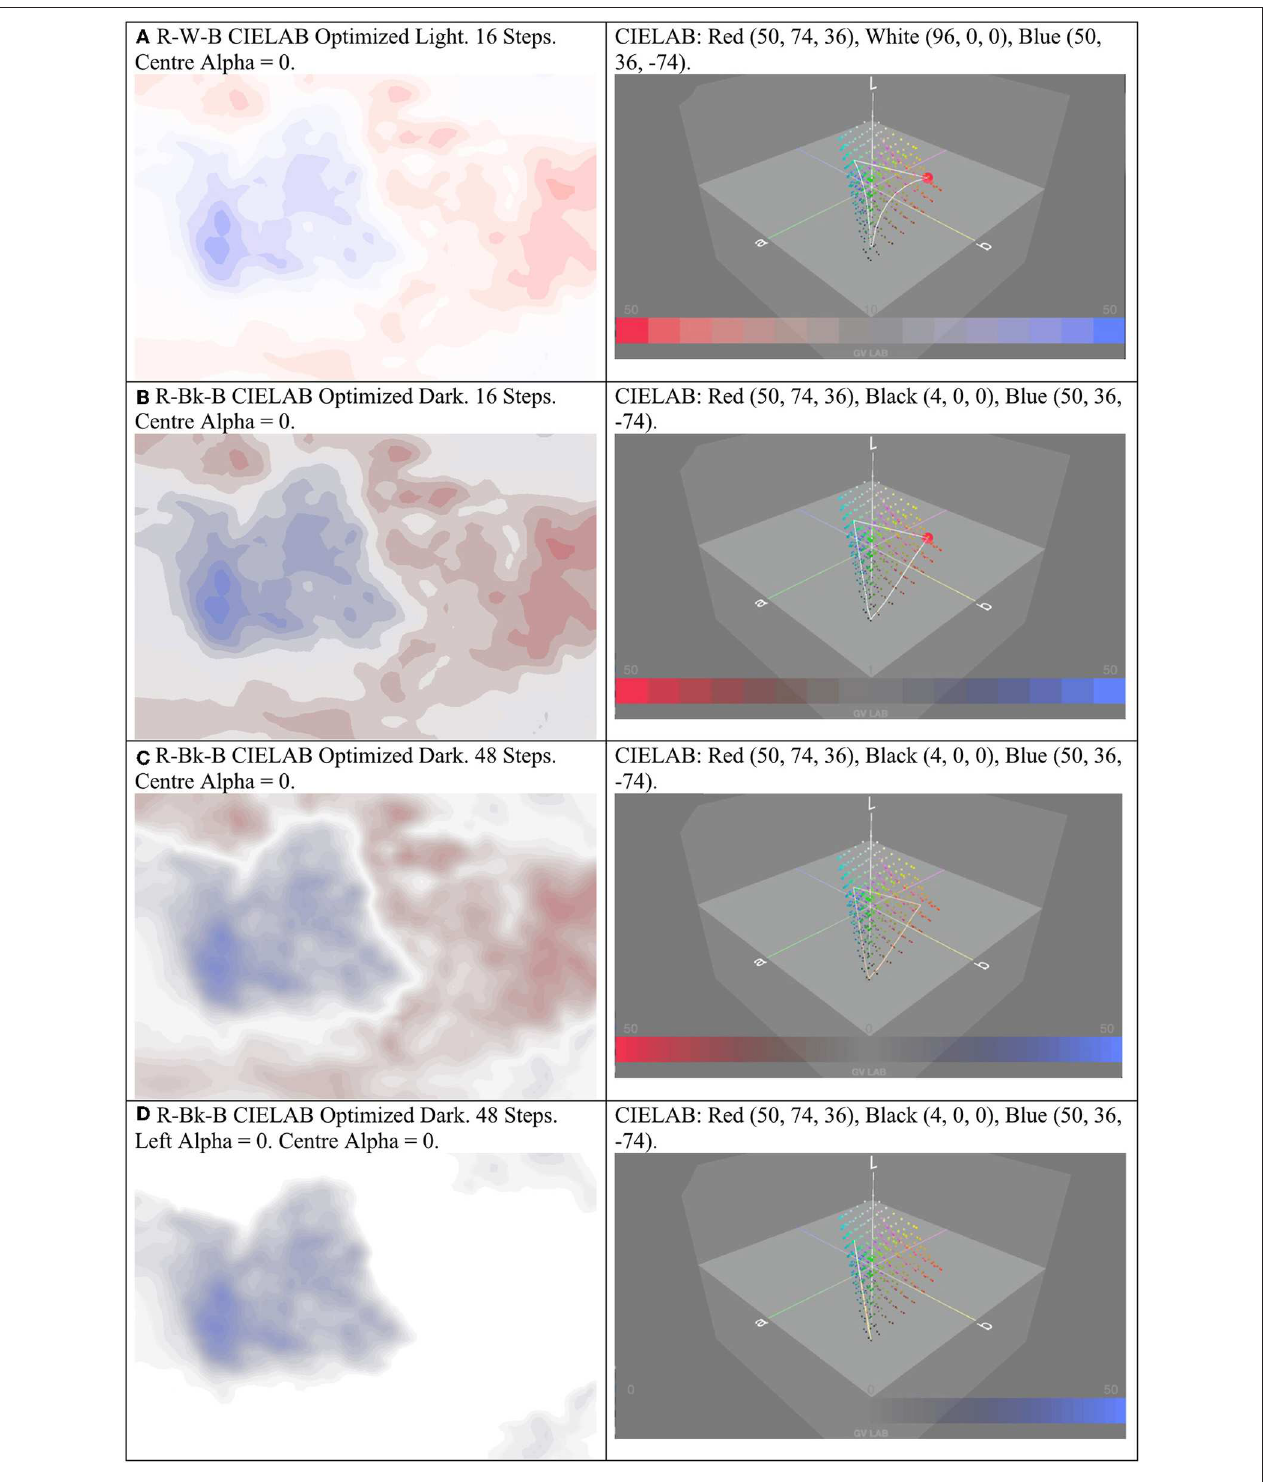
FIGURE 7 | Detailed 2D Views and preparation for 3D. Visualizations generated using the Gradient Designer and LAB Color Mixer Apps (left column) shown with supporting insights in CIELAB color space provided through the GV_LAB App (right column). Note: images contain alpha channels composited against white background. (A) R-W-B gradient as per 6 (C) , Center Alpha = 0; (B) R-Bk-B CIELAB Optimized Dark, 16 steps, Center Alpha = 0; (C) R-Bk-B CIELAB Optimized Dark, 48 steps, Center Alpha = 0; (D) R-Bk-B CIELAB Optimized Dark. 48 Steps. Left Alpha = 0. Center Alpha = 0. CIELAB colorspace conversions use D 65 2 ◦ illuminant. High resolution:https://doi.org/10.5281/zenodo.3264037.